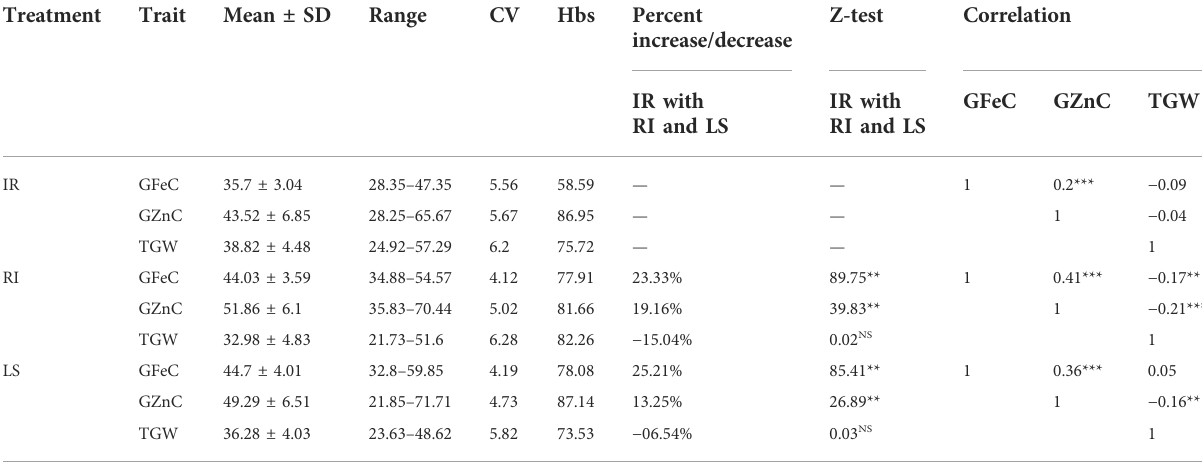
TABLE 1 Summary and correlation of GFeC, GZnC, and TGW under IR, RI, and LS treatments in the GWAS panel evaluated at Delhi 2020 – 21. Treatment Trait